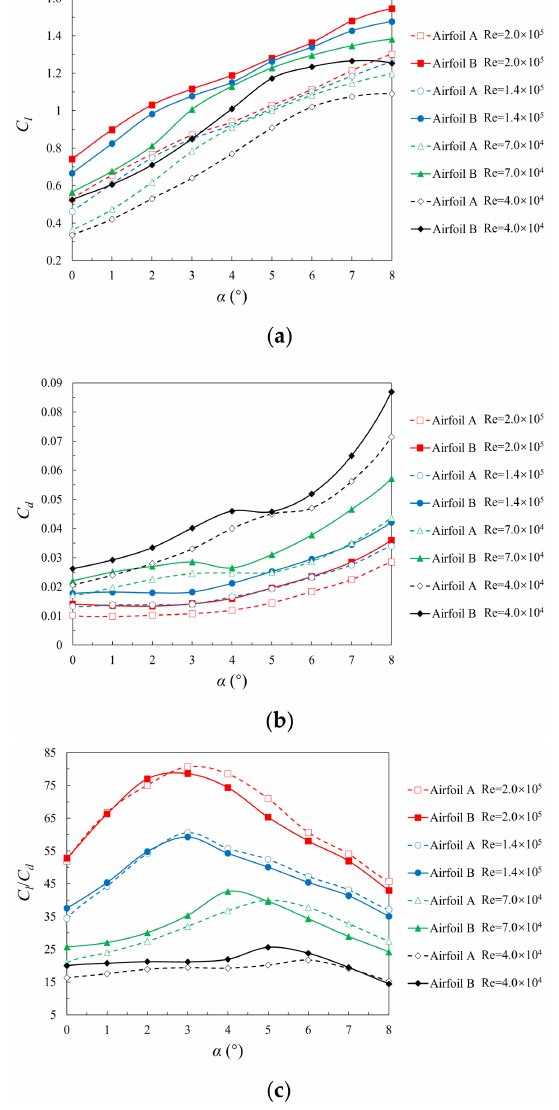
Figure 31. Aerodynamic performance of Airfoil A, and Airfoil B at different Reynolds numbers: ( a ) Lift coefficient vs. angle of attack; ( b ) Drag coefficient vs. angle of attack; ( c ) Lift-to-drag ratio vs. angle of